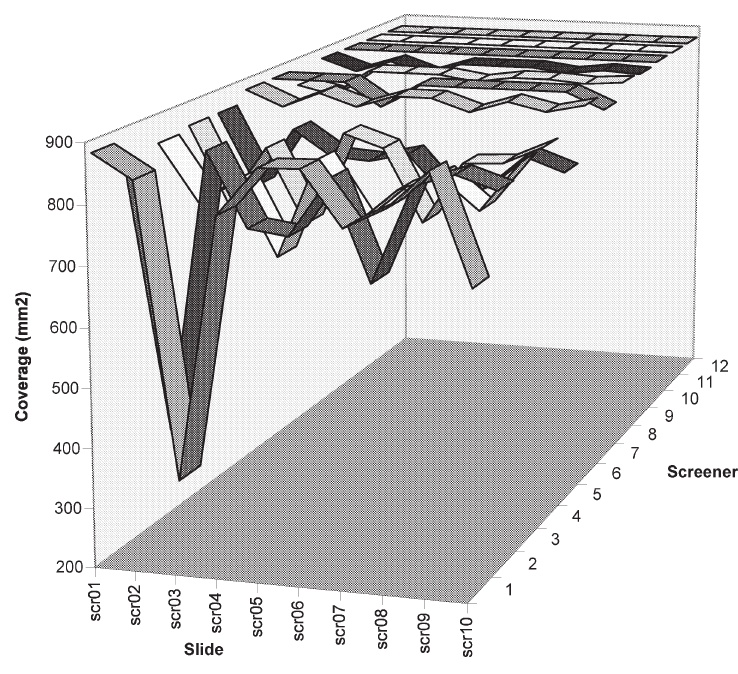
Fig. 4. Slide coverage for individual